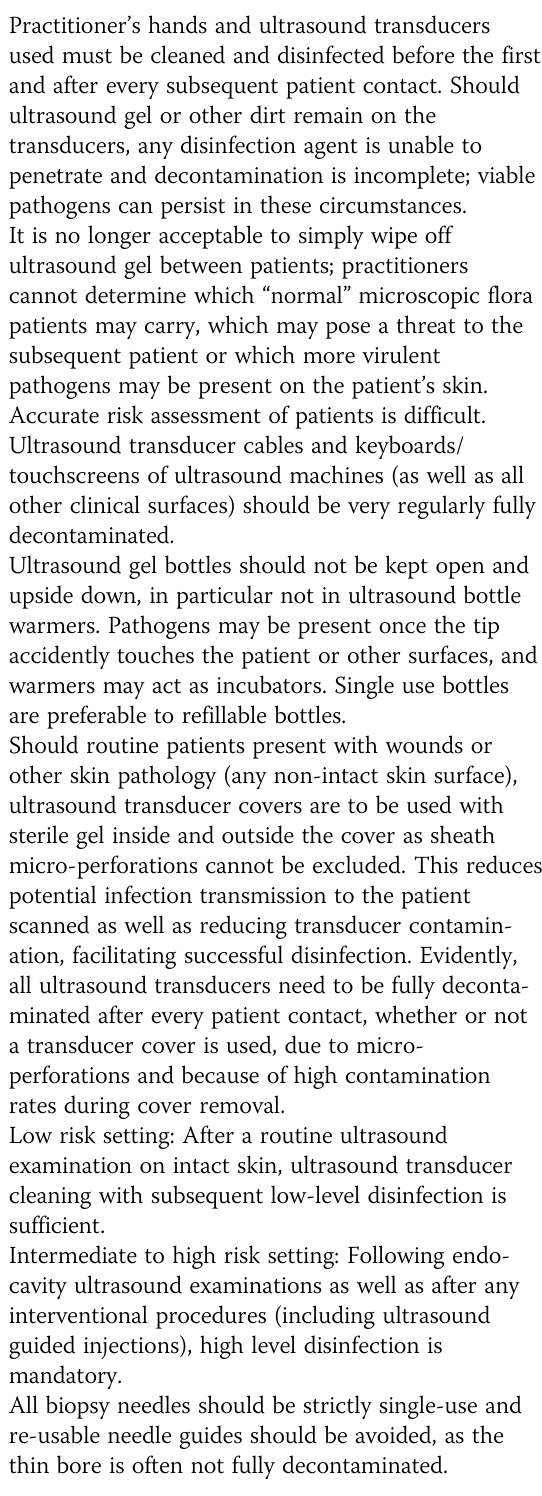
Table 2 Advanced ultrasound maintenance System Service Transducer Test Parts Replacement Software Update